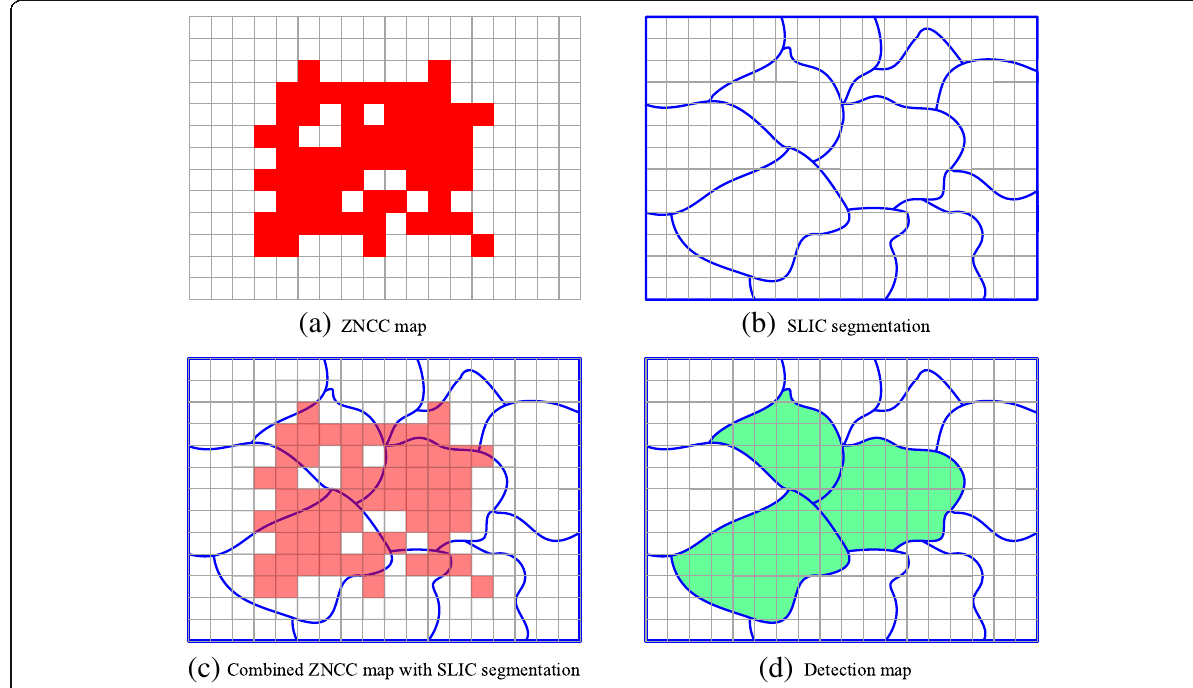
Fig. 8 The profile of the detection map. a ZNCC map. b SLIC segmentation. c Combined ZNCC map with SLIC segmentation. d Detection